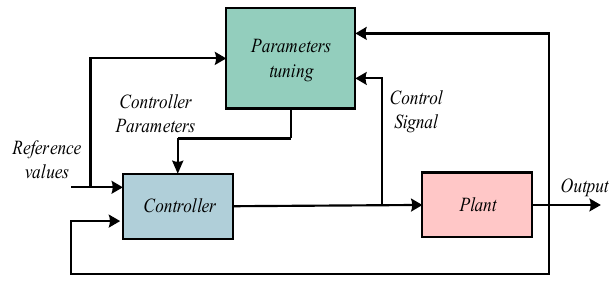
Figure 31. Block diagram of Adaptive control algorithm.